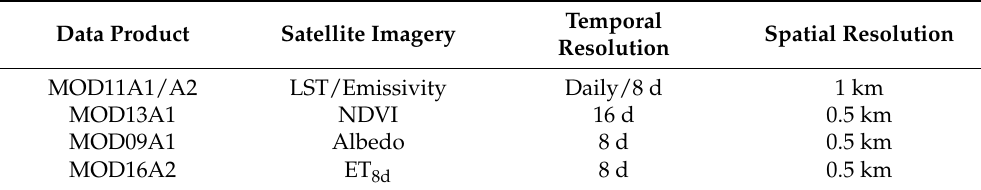
Table 1. Detailed information of the MODIS